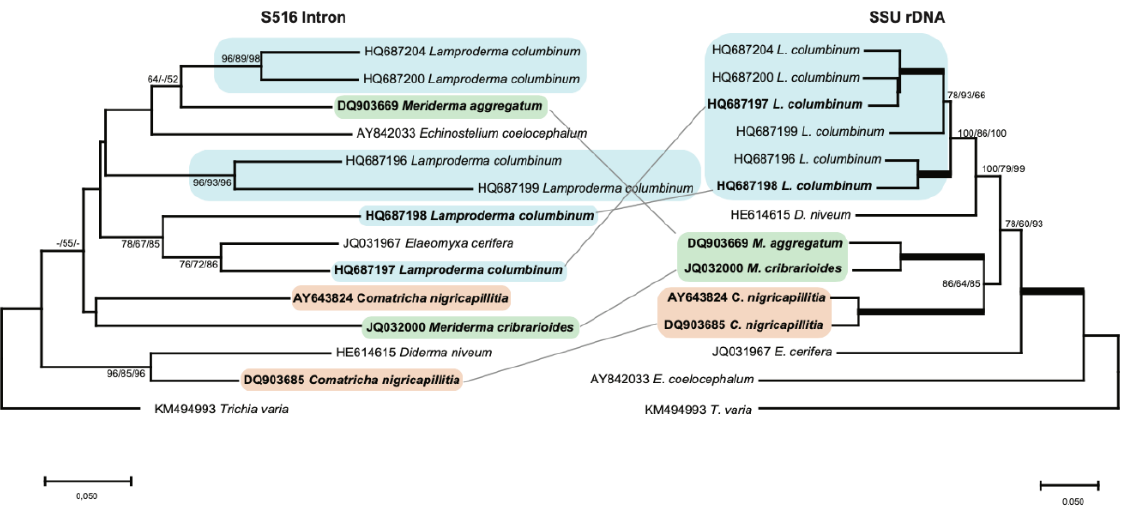
Figure 3. Molecular phylogeny of S516 group I introns as candidates to horizontal transfer. The intron and SSU topology is obtained by neighbor-joining (NJ) analysis of 14 taxa and 143-nt aligned positions (intron dataset 2; Table S1) and 1784-nt aligned positions (SSU rDNA dataset 2; Table S1). The NJ, maximum likelihood (ML), and minimal evolution (ME) bootstrap replicates ( ≥ 50%) are given for each node. Isolates observed as horizontal inheritance candidates are shown in bold letters. Bold branches in the SSU rDNA tree indicate maximum support in NJ ( ≥ 98%), ML, and ME ( ≥ 98%). The scale bar indicates the fraction of substitutions per site.